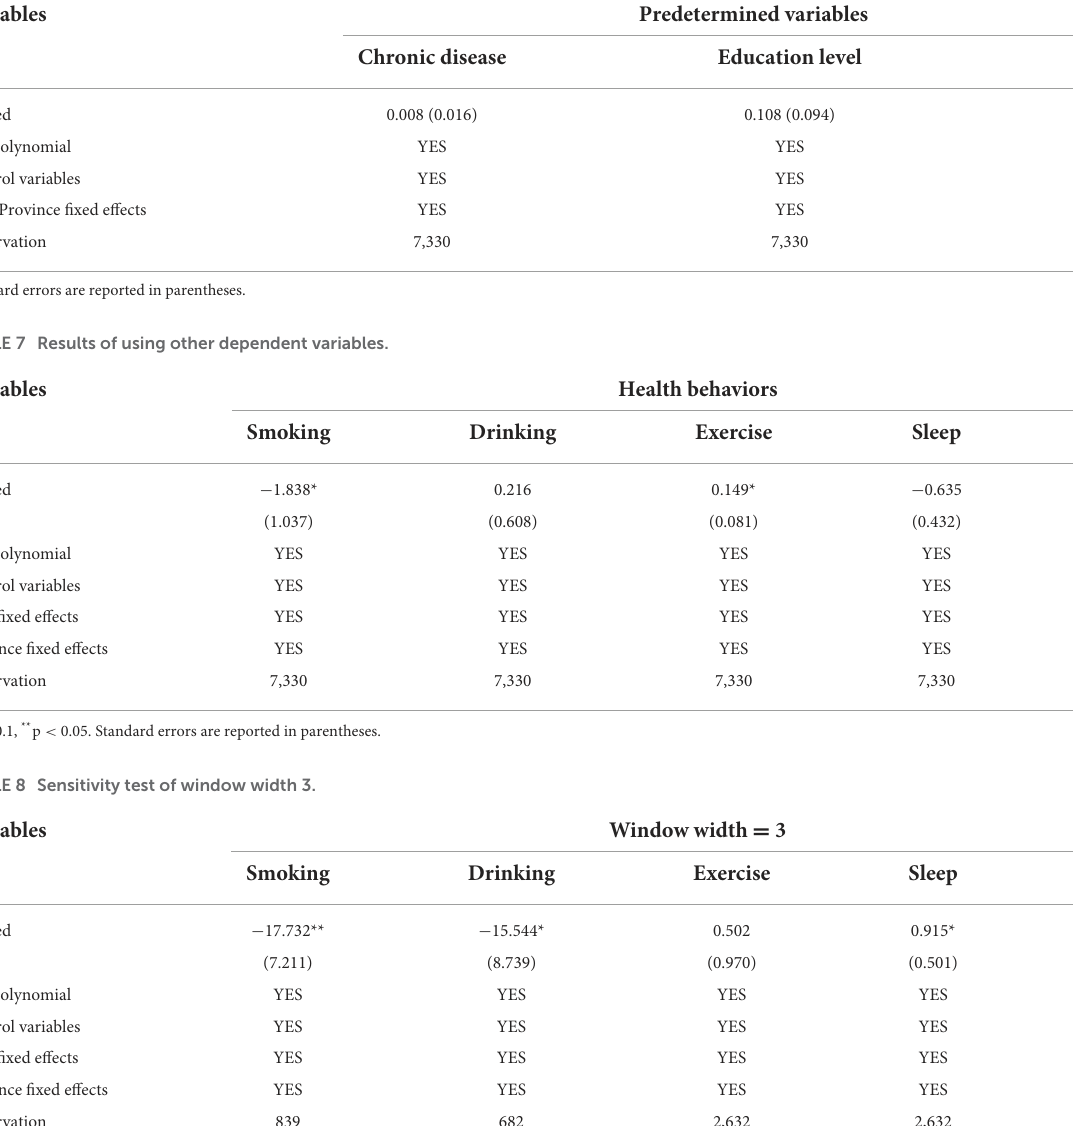
TABLE 6 Continuity test of predetermined variables.